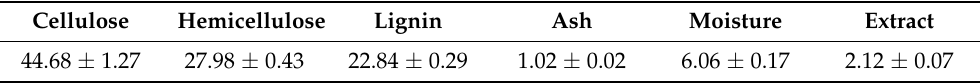
Table 1. Content of bagasse biomass (%).